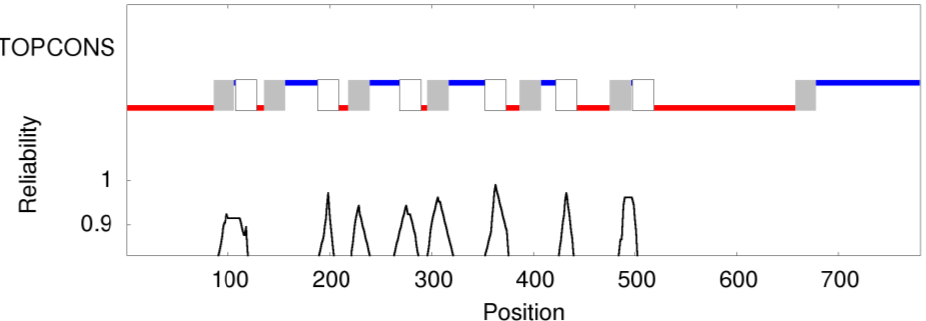
Figure 1. Membrane topology prediction for the protein expressed by SLC26A4 (pendrin) according to TOPCONS [27]. Boxes refer to the transmembrane (TM) region (in vs. out, grey; out vs. in, white); red lines refer to intracellular regions; blue lines refer to extracellular regions. X-axis refers to the position within protein sequence. Reliability estimate of the predictions is reported in the Y-axis.